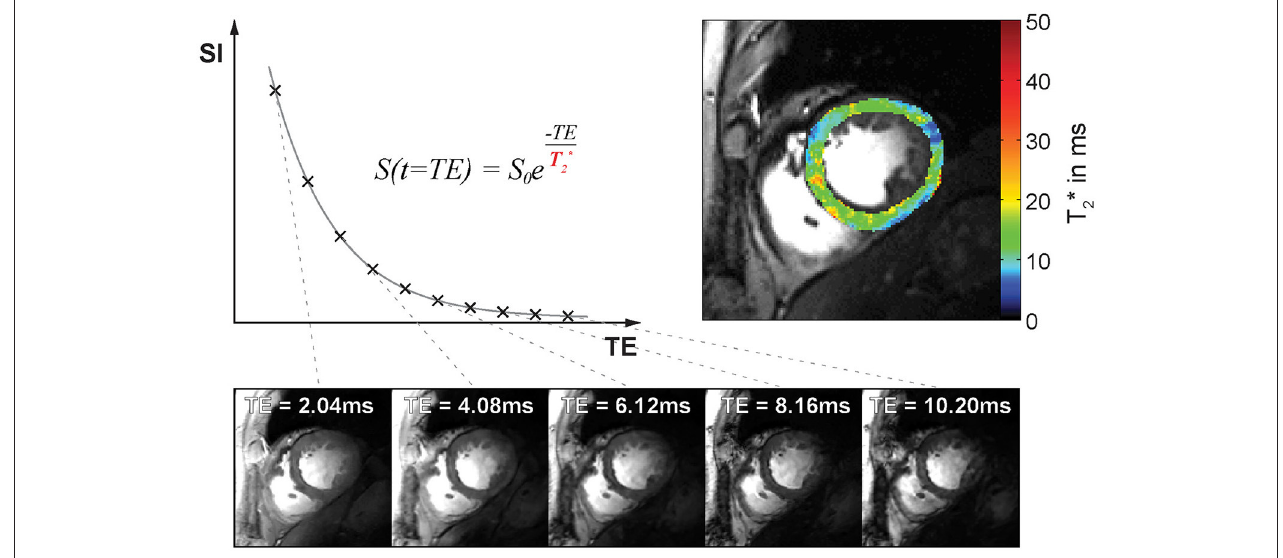
FIGURE 1 | T 2 * decay and T 2 * -weighted image contrast. Top left: Plot of signal intensity over echo time for T 2 * weighted imaging. Bottom: Example of mid-ventricular short axis views of the human heart obtained at 7.0 T. Images were acquired with increasing T 2 * -weighting (from left to right). Top right: Corresponding myocardial T 2 * map superimposed to a FLASH CINE